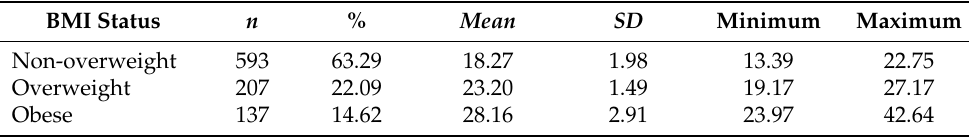
Table 1. Descriptive statistics of BMI status.